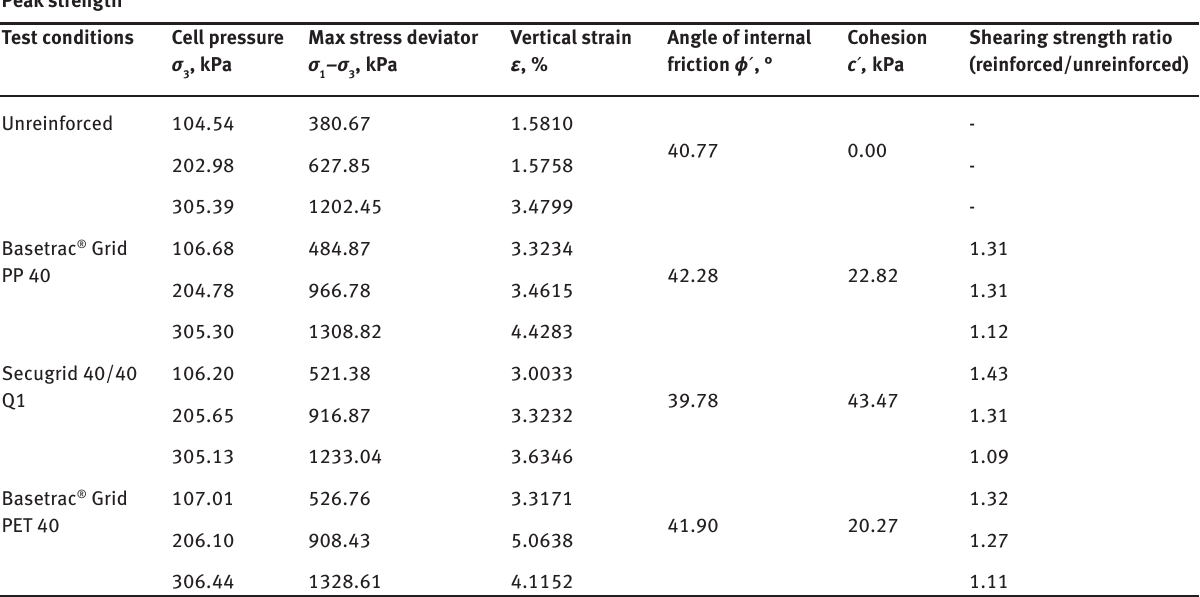
Table 3: Unreinforced and reinforced soil with geogrid shearing strength. Peak strength Test